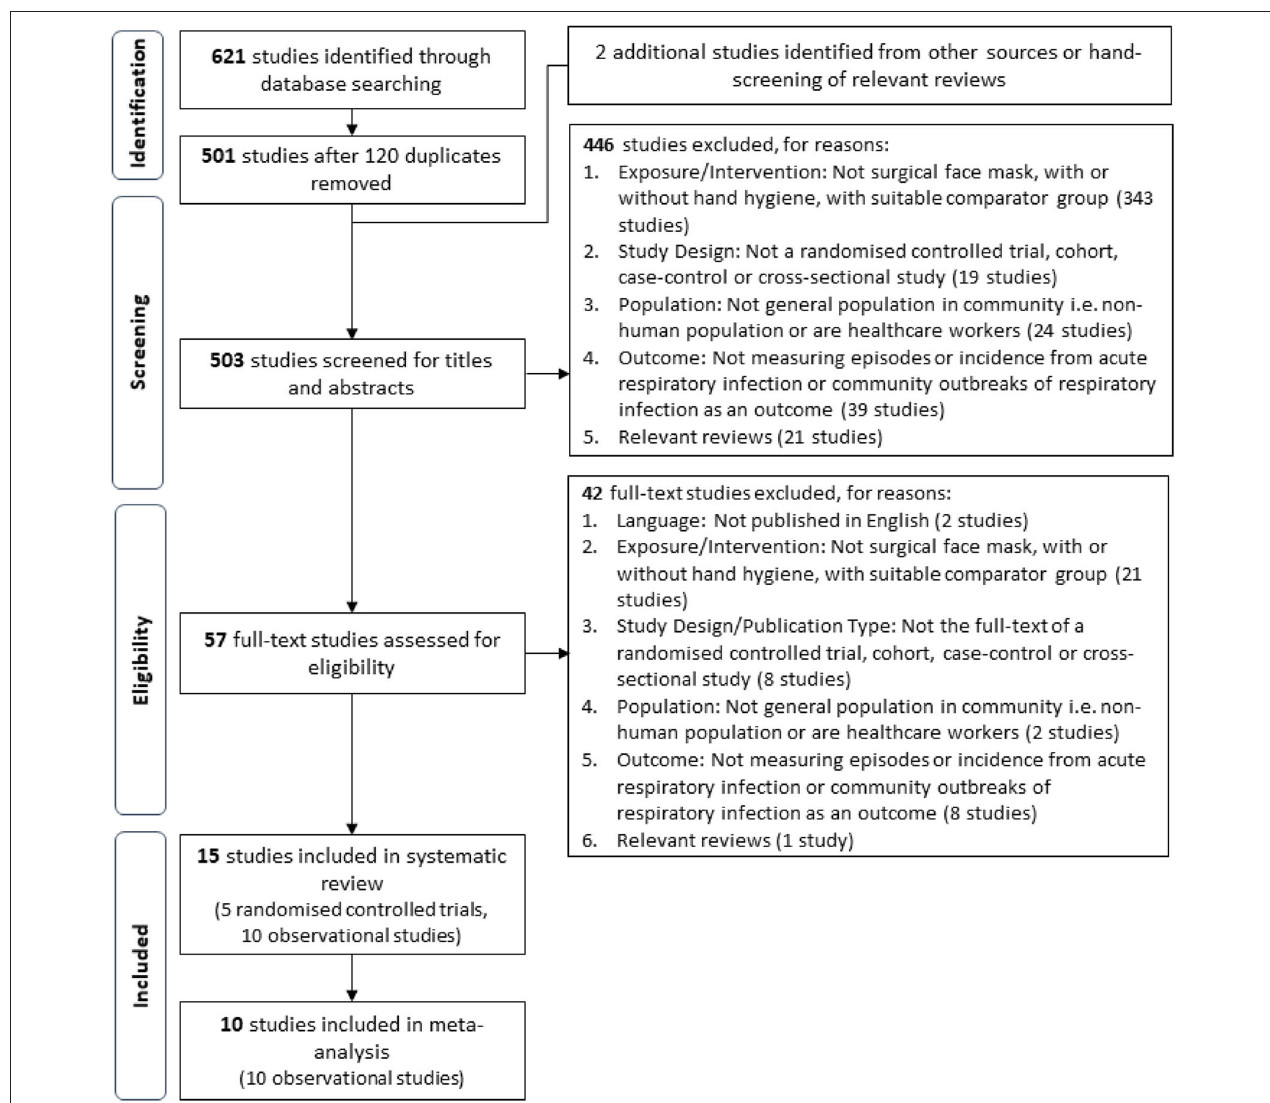
FIGURE 1 | Flowchart of the process of screening and study